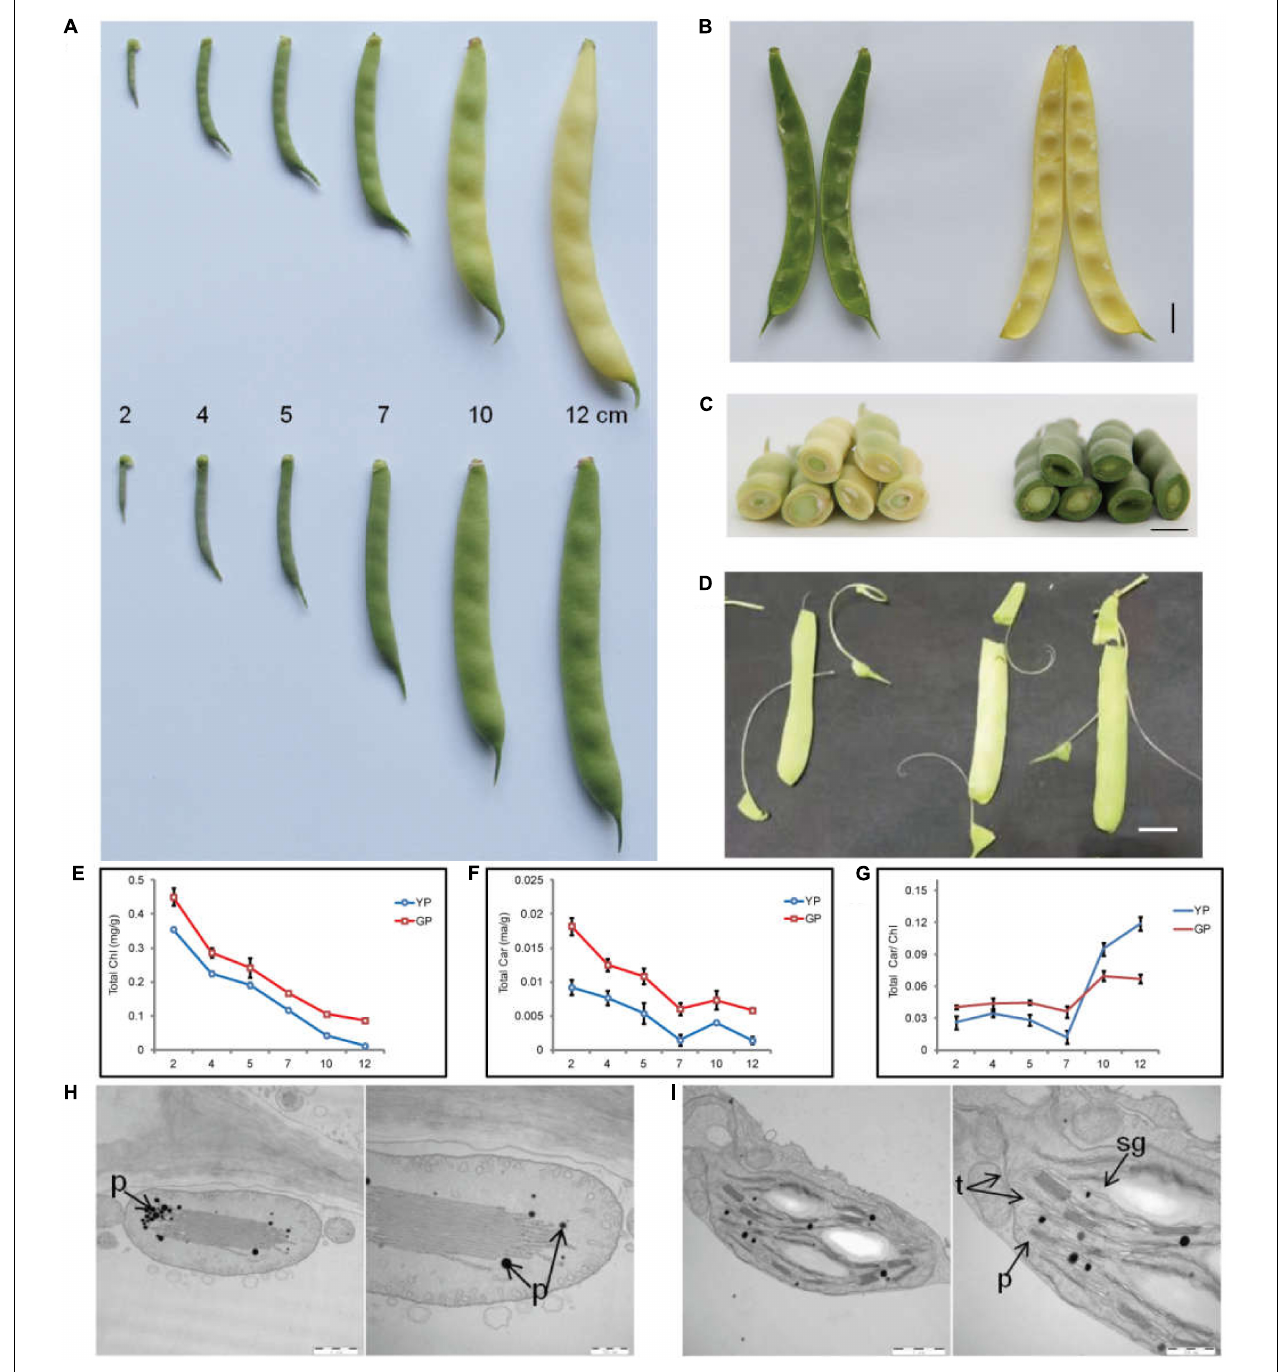
FIGURE 1 | Pod color conversion, pigment content changes, and chloroplast microstructure during pod development. (A) Phenotypes of common bean pods of wild type (YP) and green pod mutant (GP). (B,C) phenotypes of pod interior and cross-section of the wild type and green pod mutant. (D) Phenotypes of green pod mutant with high cellulose content in the pods. (E–G) Total chlorophyll and carotenoid contents and the Car/Chl ratio at all developmental stages. (H,I) Structure of chloroplasts from wild type (H) and mutant (I) ; t, thylakoids, sg, starch grain, p, plastoglobuli. Scale bar: 1 µ m and 500 nm.